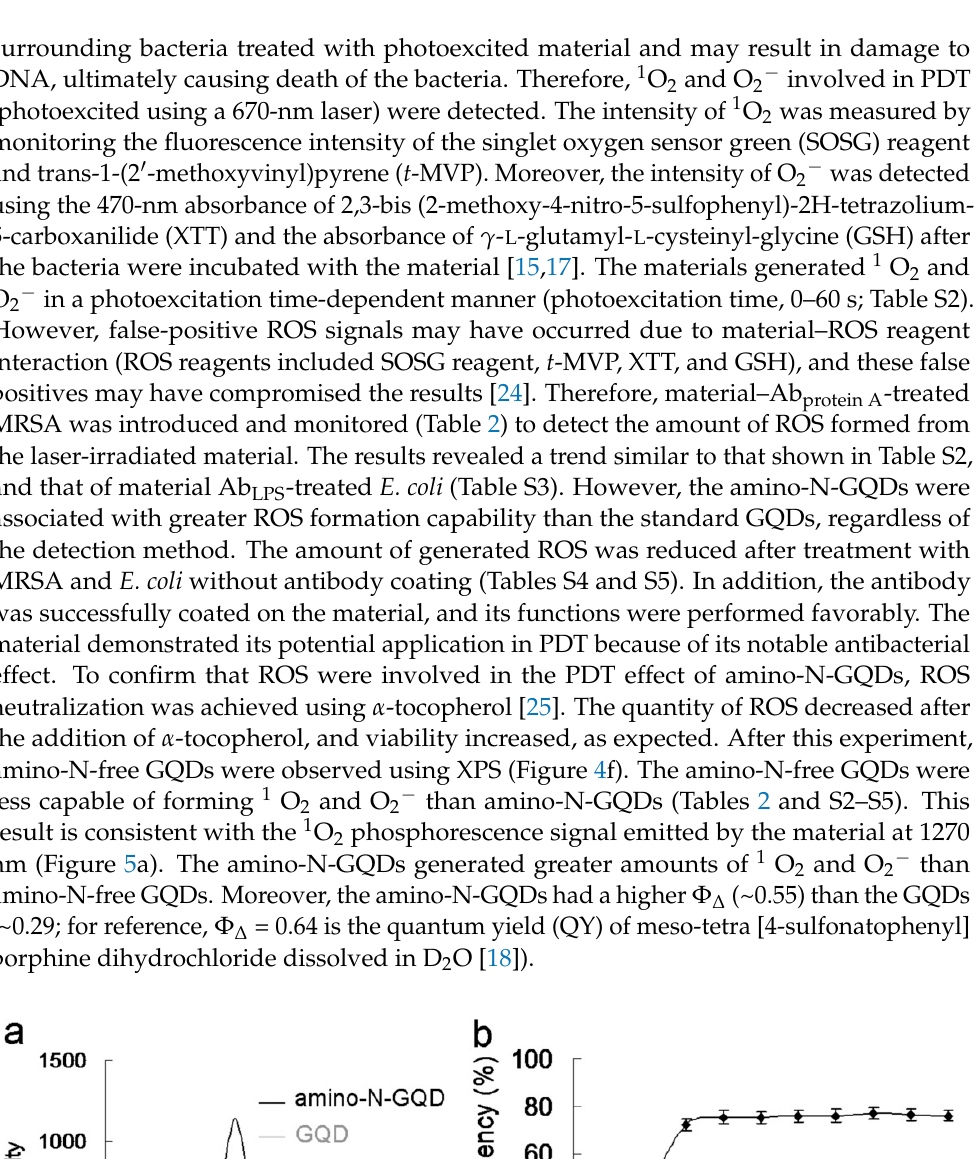
Figure 5. ( a ) Phosphorescence spectra measured at 1270 nm for amino-N-GQDs and GQDs. Delivered dose: 0.5 μ g·mL − 1 for material. ( b ) Uptake assay of MRSA and amino-N-GQD–Ab protein A , conducted at 37 °C for 10 h. Delivered dose: OD 600 = ~0.05 μ g·mL − 1 for bacteria and 0.5 μ g·mL − 1 for amino-N-GQD–Ab protein A . Data are presented as mean ± SD ( n = 6).